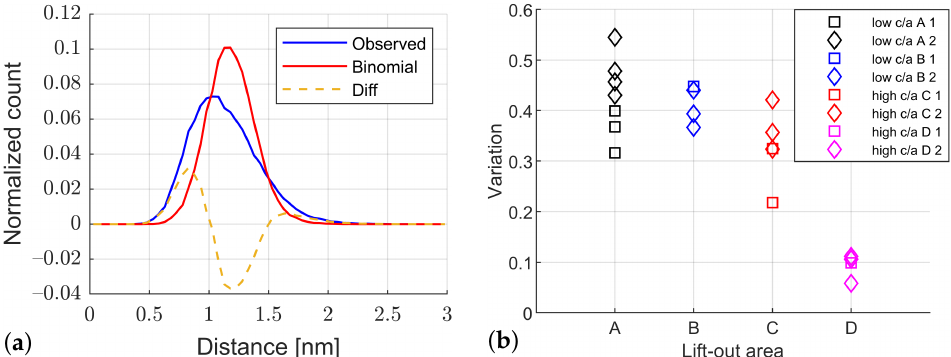
Figure 4. ( a ) ‘Observed’ and binomial normalized fifth order NN distribution with their difference in ROI of B2 with a variation value of 0.44. ( b ) Variation of fifth order NN distribution for ROI of APT tips from lift-out regions A–D with varying low and high tetragonality c / a